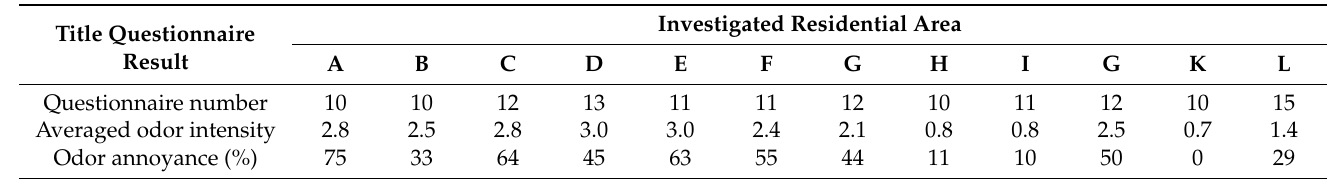
Table 1. The questionnaire number, averaged odor intensity and odor annoyance by respondents in investigated residential areas